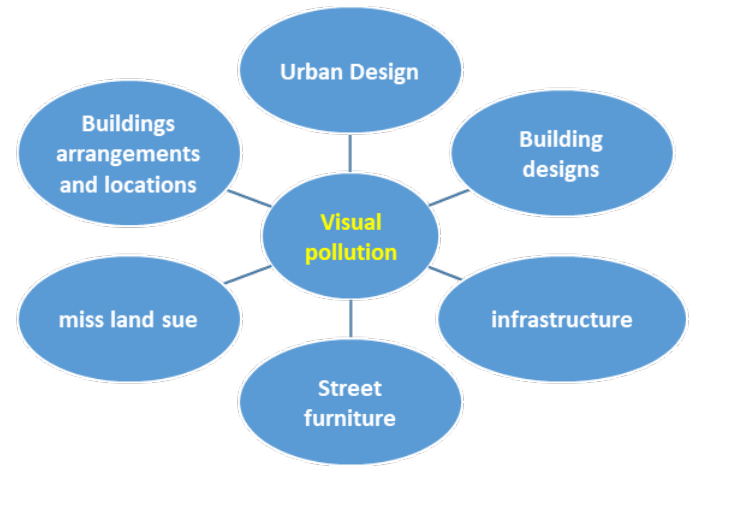
Figure 12. Common causes for visual pollution in study